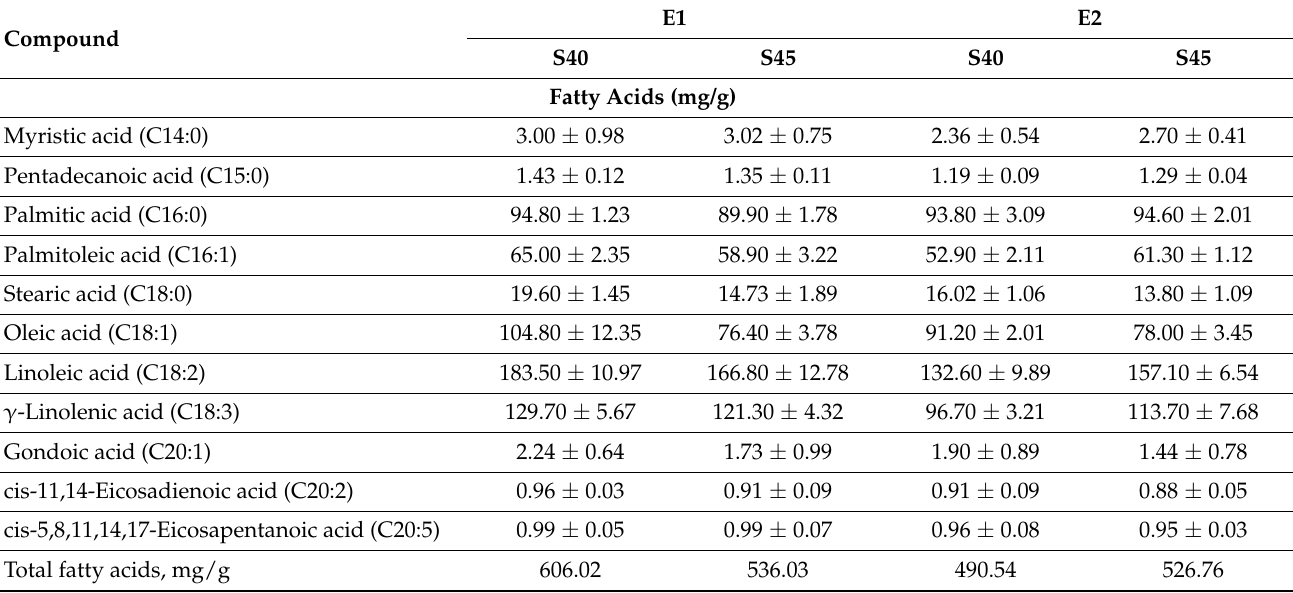
Table 2. Fatty acid and carotenoid profiles of the SFE-CO 2 SBP oil